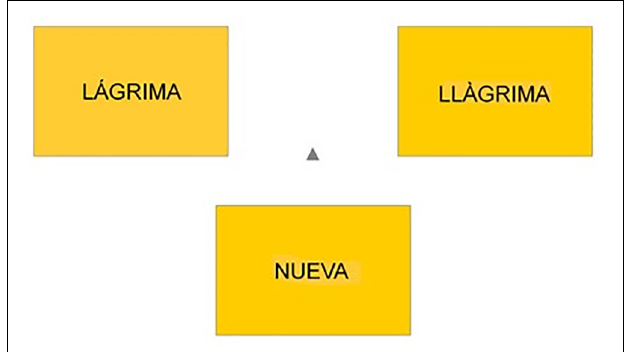
FIGURE 1 | Screenshot of a trial in the test phase. Both words in the upper two boxes mean ‘tear,’ the Spanish word on the left and the Catalan word on the right. The box below contains the Spanish word for